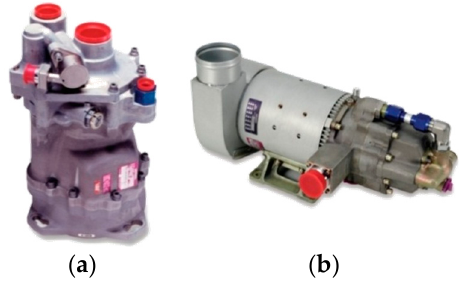
Figure 1. ( a ) Aircraft engine driven pump; ( b ) Aircraft engine motor driven pump.